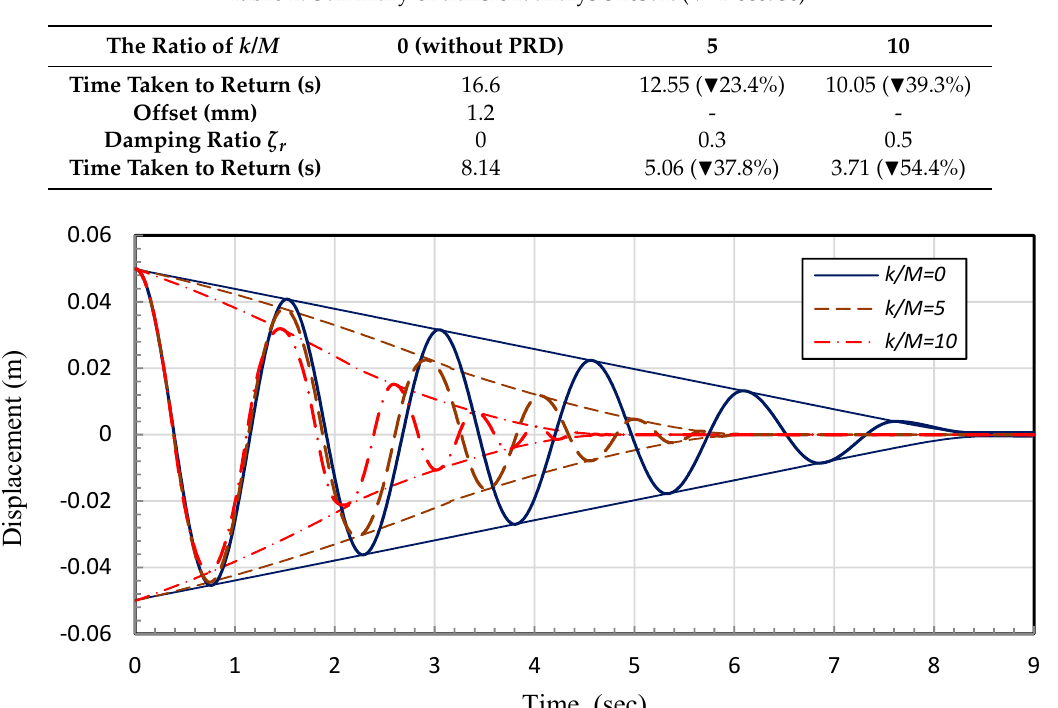
Figure 5. Transient response and envelope for the seismic isolation system (RIS) with PRD (initial displacement = 0.05 mm, k / M = 0, 5, 10 and ζ r = 0.3 ).